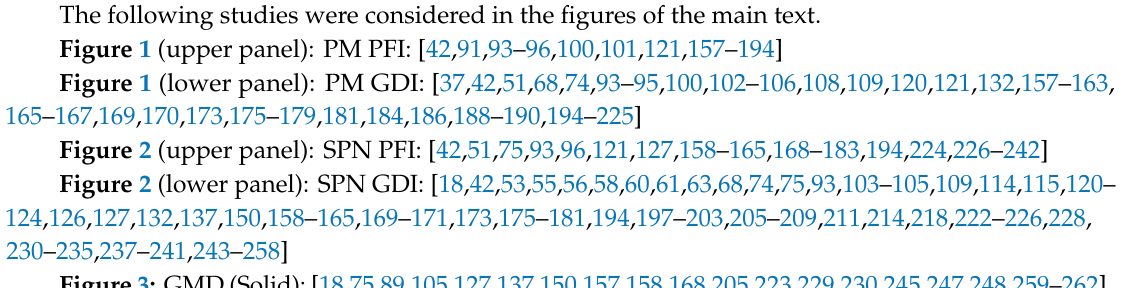
Figure 3: GMD (Solid):